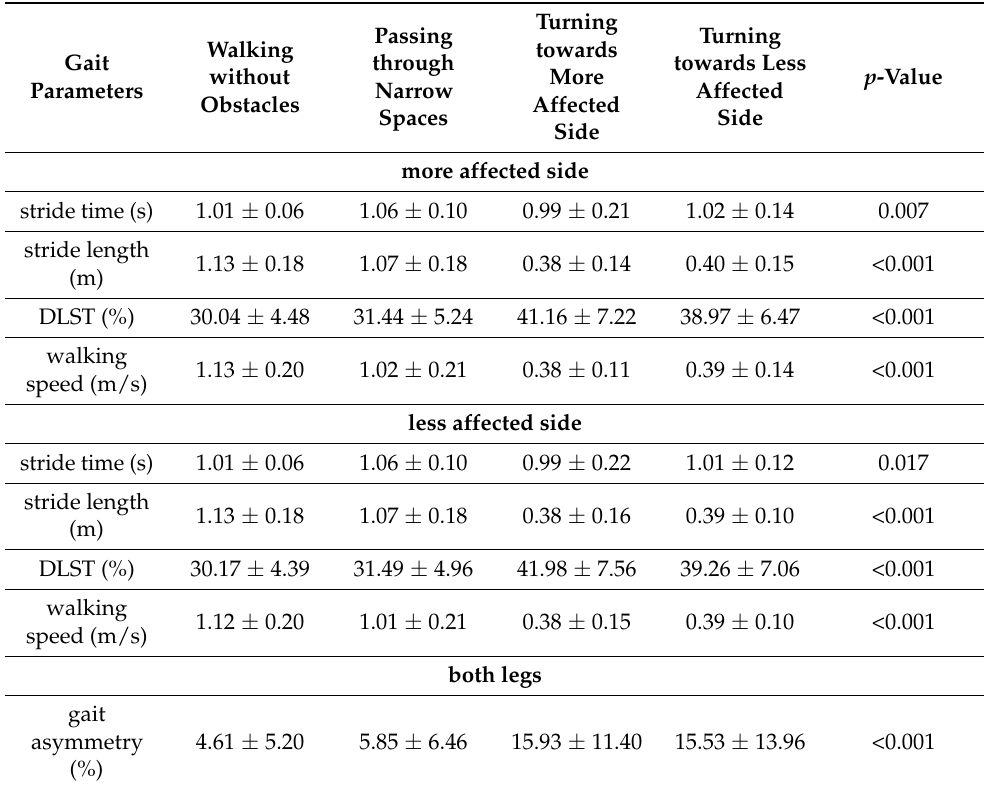
Table 3. Gait parameters at